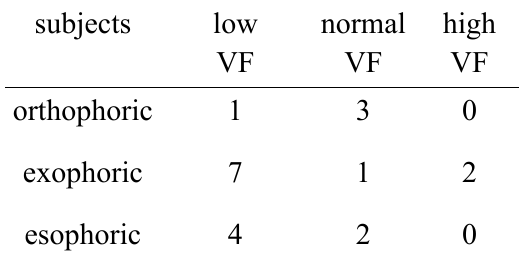
Table 9: Regression table for the linear mixed- effects model for the